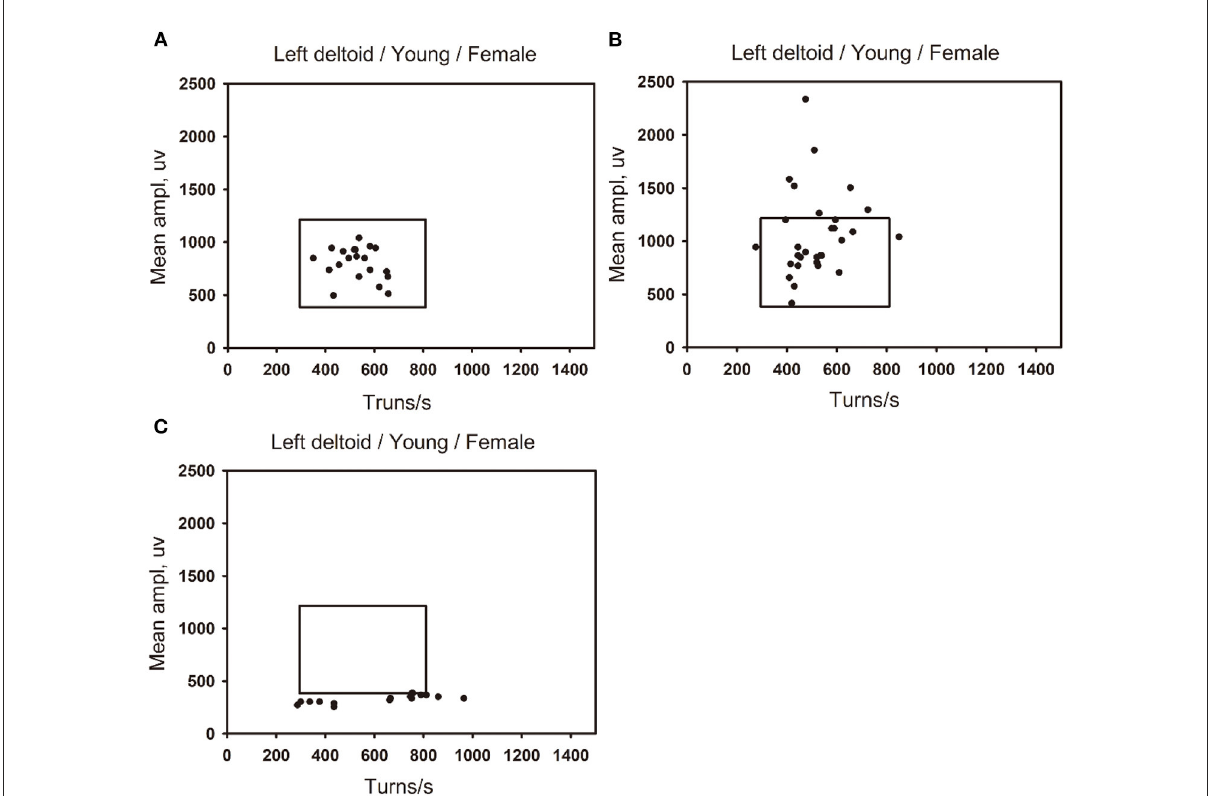
FIGURE8 The distribution of data points for normal, neuropathic lesion, and myopathic lesion muscles in the percentile clouds. The percentile clouds of left deltoid muscle in three young women (18–44 years old). (A) The left deltoid muscle of a young women is defined as normal, with the muscles data points distributed within the linear regression cloud. (B) The left deltoid muscle of a young women is defined as neuropathic lesion, with the data points of muscle beyond the upper boundary of the percentile cloud, which exceed 20% of all data points. (C) The left deltoid muscle of a young women is defined as myopathic lesion, with the data points of muscle beyond the lower and right boundaries of the percentile cloud, which exceed 30% of all data